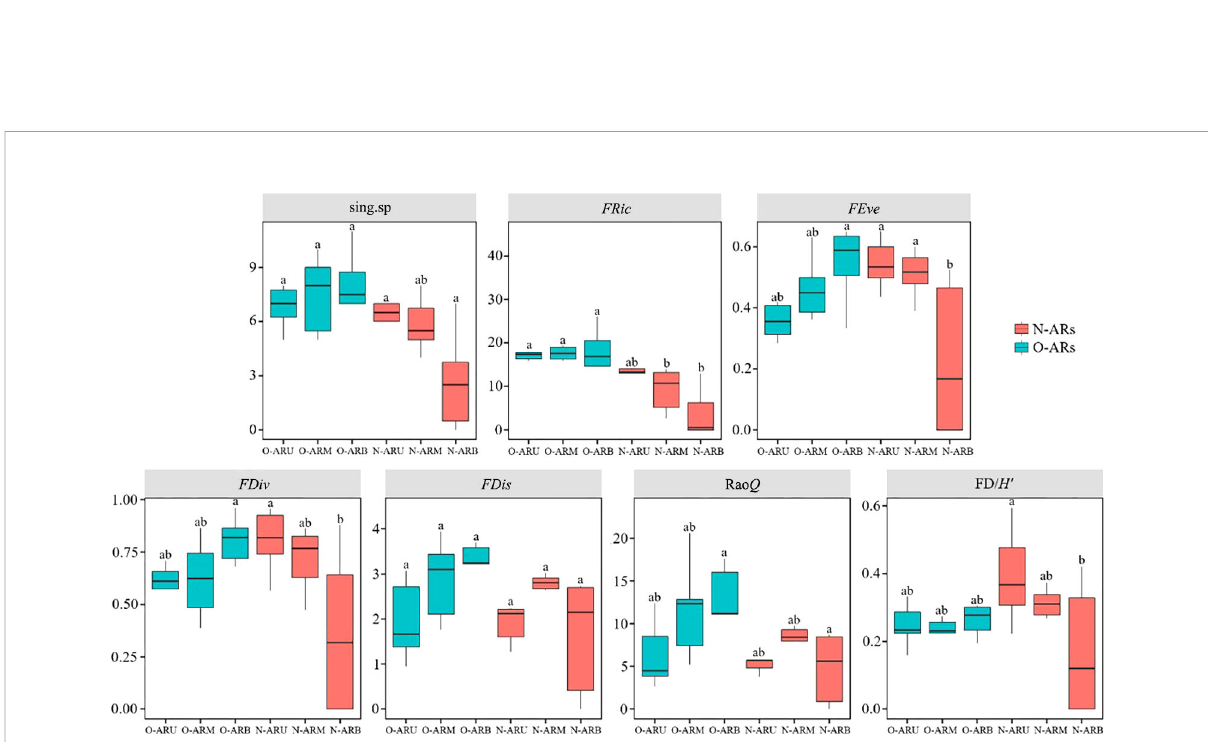
FIGURE 6 Functional diversity analysis of attached communities at each sampling location on the ARs with different construction times: the number of single-function species (sing.sp), the functional richness index ( FRic ), the functional evenness index ( FEve ), the functional divergence index ( FDiv ), the functional dispersion index ( FDis ), Rao ’ s quadratic entropy index (Rao Q ) and the functional redundancy index (FD/ H ′ ). Different letters (a,b) above the bars indicate signi fi cant differences between sampling